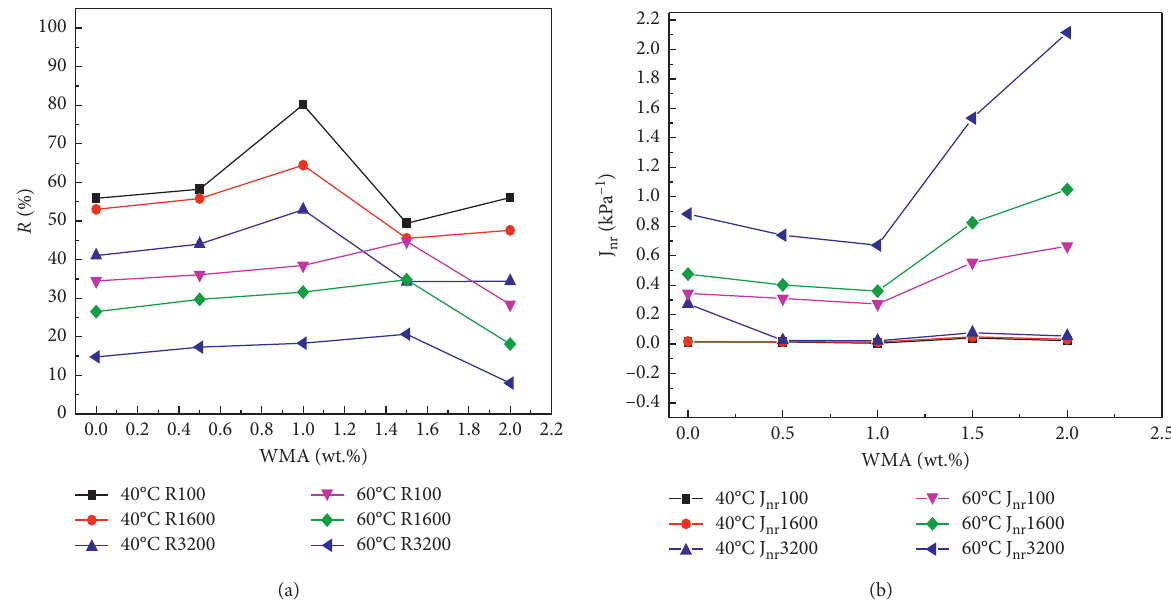
Figure 8: (a) The percent recovery and (b) nonrecoverable creep compliance calculated from the MSCR test at 40 ° C and 60 ° C and three stress levels for warm-mix